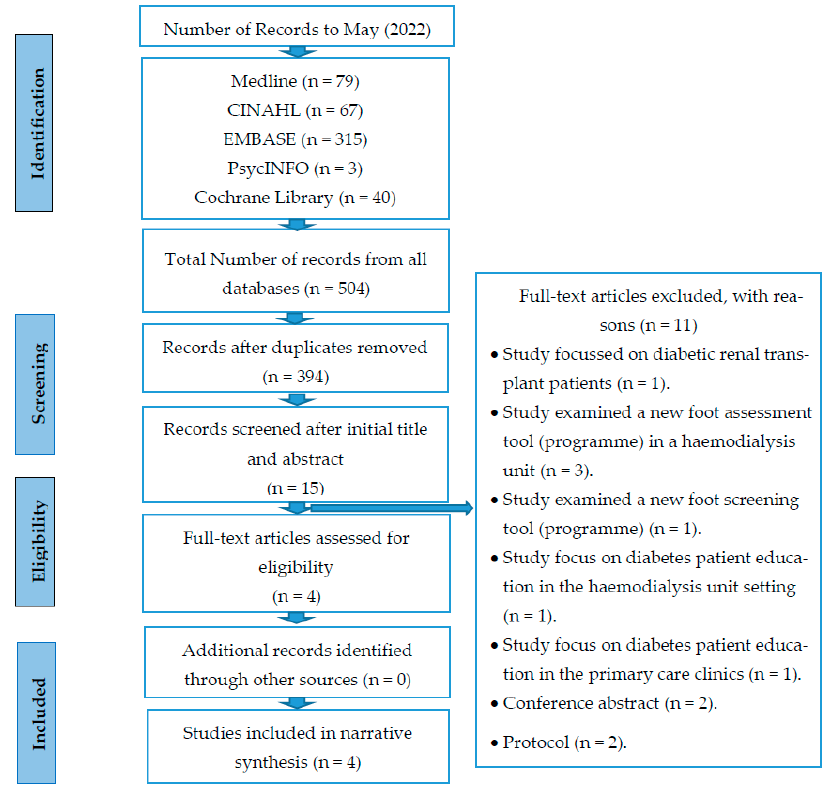
Figure 1. PRISMA 2009 flow diagram for the process of study selection.